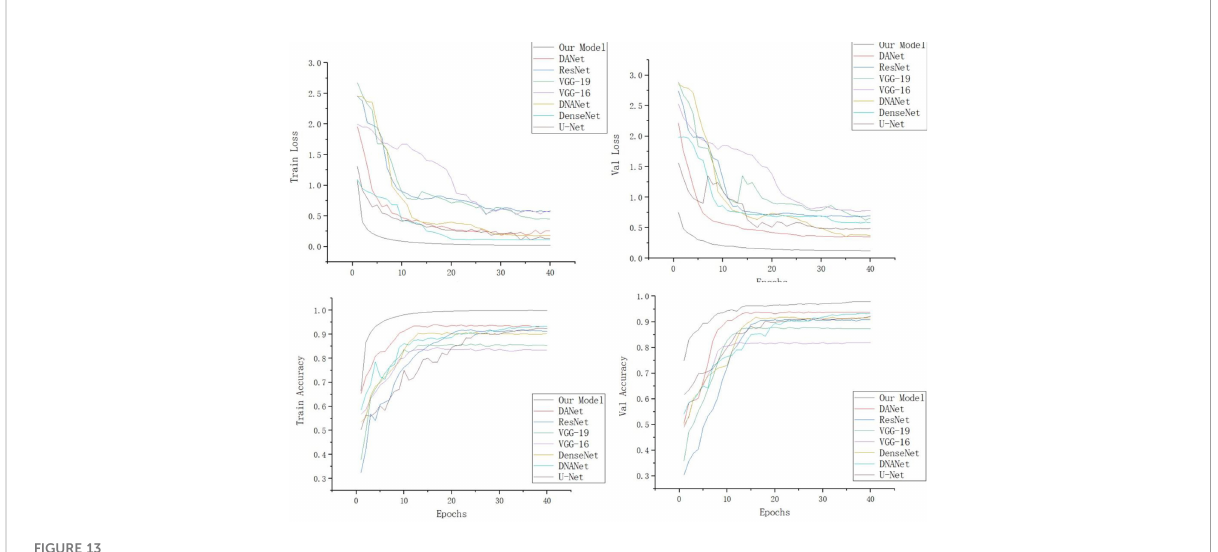
FIGURE 13 Loss rate and accuracy function images of each model.